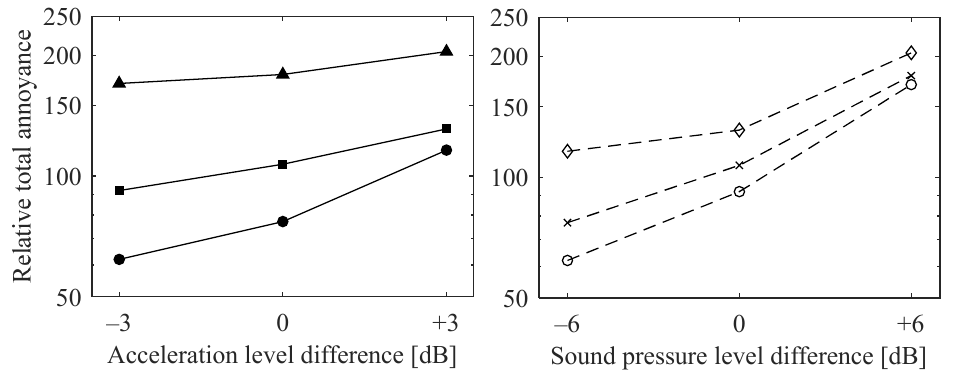
Figure 7. Interaction diagrams of the mini excavator scene (sound pressure level, acceleration level); figure on the left: sound pressure level difference ● — − 6 dB ■ —0 dB ▲ —+6 dB vs. acceleration level difference; figure on the right: acceleration level difference ○ — − 3 dB x—0 dB ◊ —+3 d vs. sound pressure level difference; N = 12.